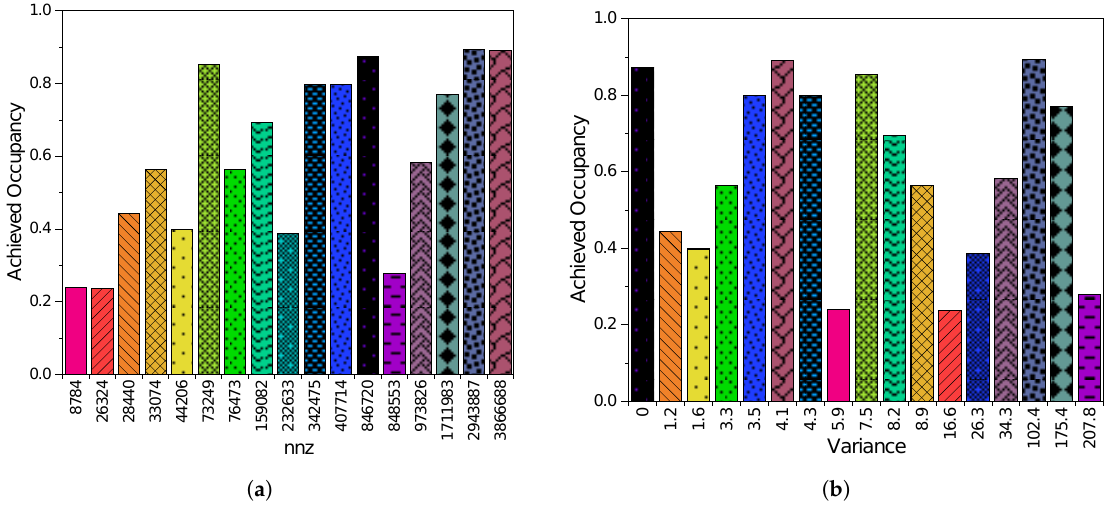
Figure 8. ELL achieved occupancy against: ( a ) nnz and ( b ) npr variance